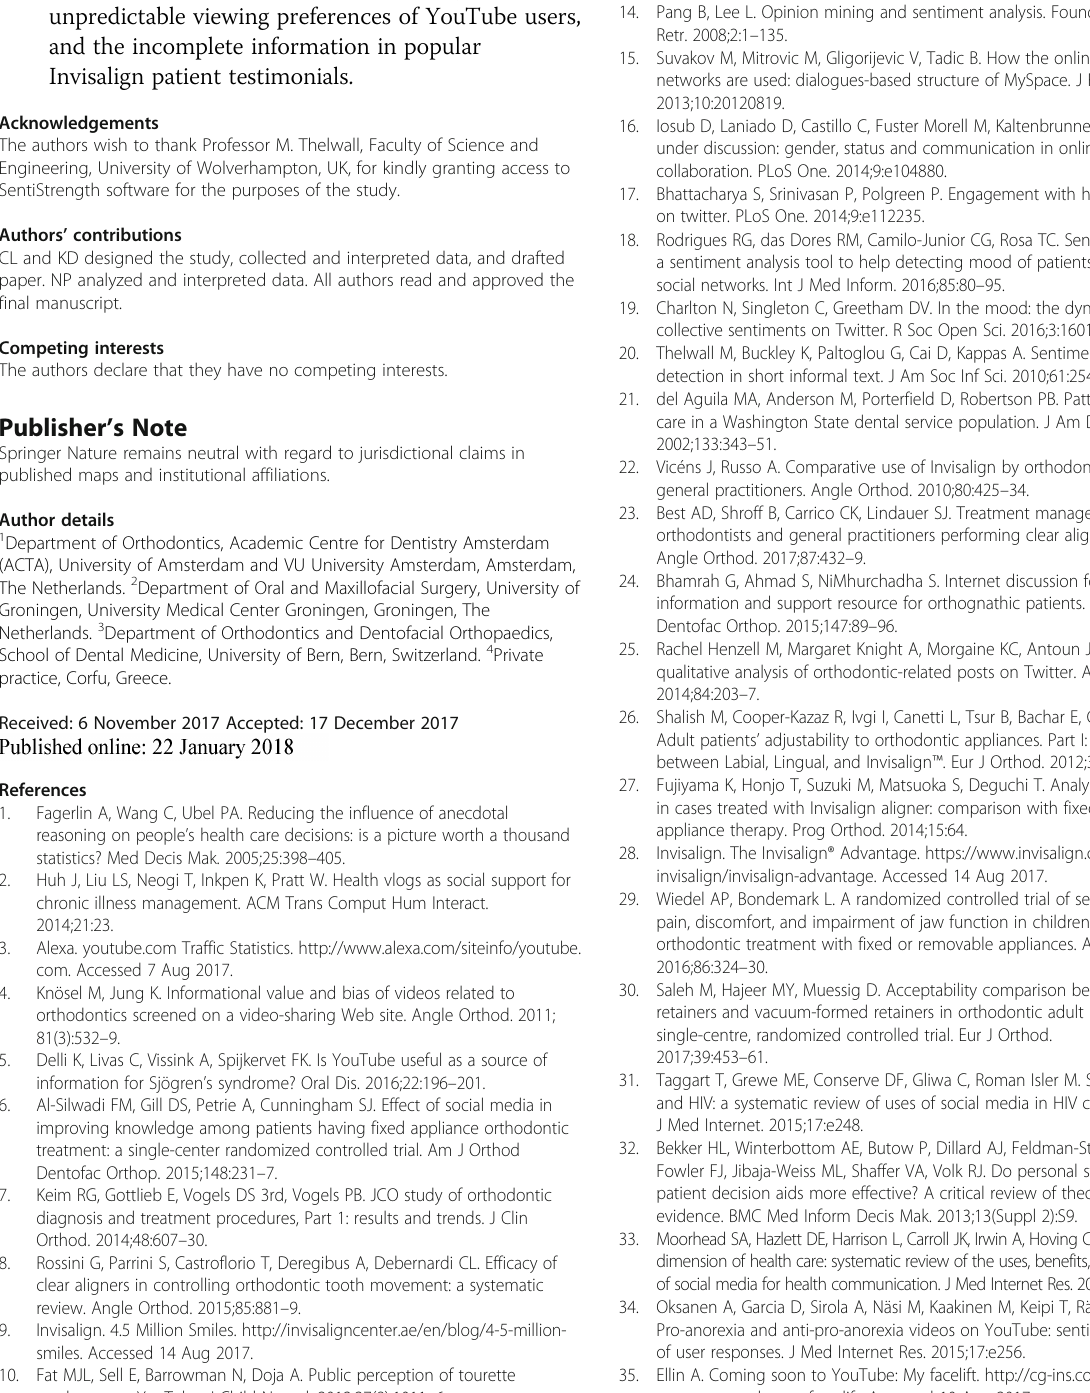
(cid:1) The emotional loading of viewers ’ comments about Invisalign aligners was significantly more positive and was significantly associated with their status, content, and sponsorship of videos. (cid:1) Range of information, video duration, and time since upload did not significantly influence engagement and view metrics, a finding that warns against the unpredictable viewing preferences of YouTube users, and the incomplete information in popular Invisalign patient